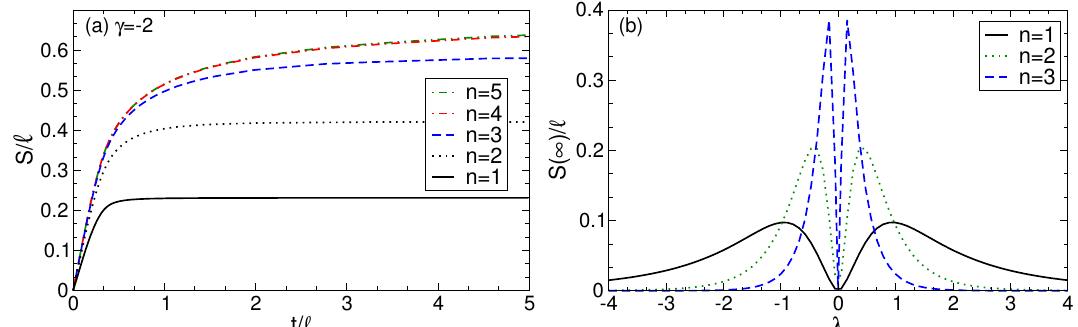
Figure 13: Entanglement dynamics after the quench from the Bose condensate in the attrac- tive Lieb-Liniger model. Panel (a) shows the entropy density S /(cid:96) plotted versus the rescaled time t /(cid:96) . The curves are Bethe ansatz results for fixed interaction strength γ = − 2 in which all the bound states with size up to n have been included in the sum (98). Panel (b). Contribu- tions of the different bound states to the steady-state entanglement entropy. S /(cid:96) is plotted as a function of the quasiparticle rapidity λ . Different lines correspond to different bound-state sizes n